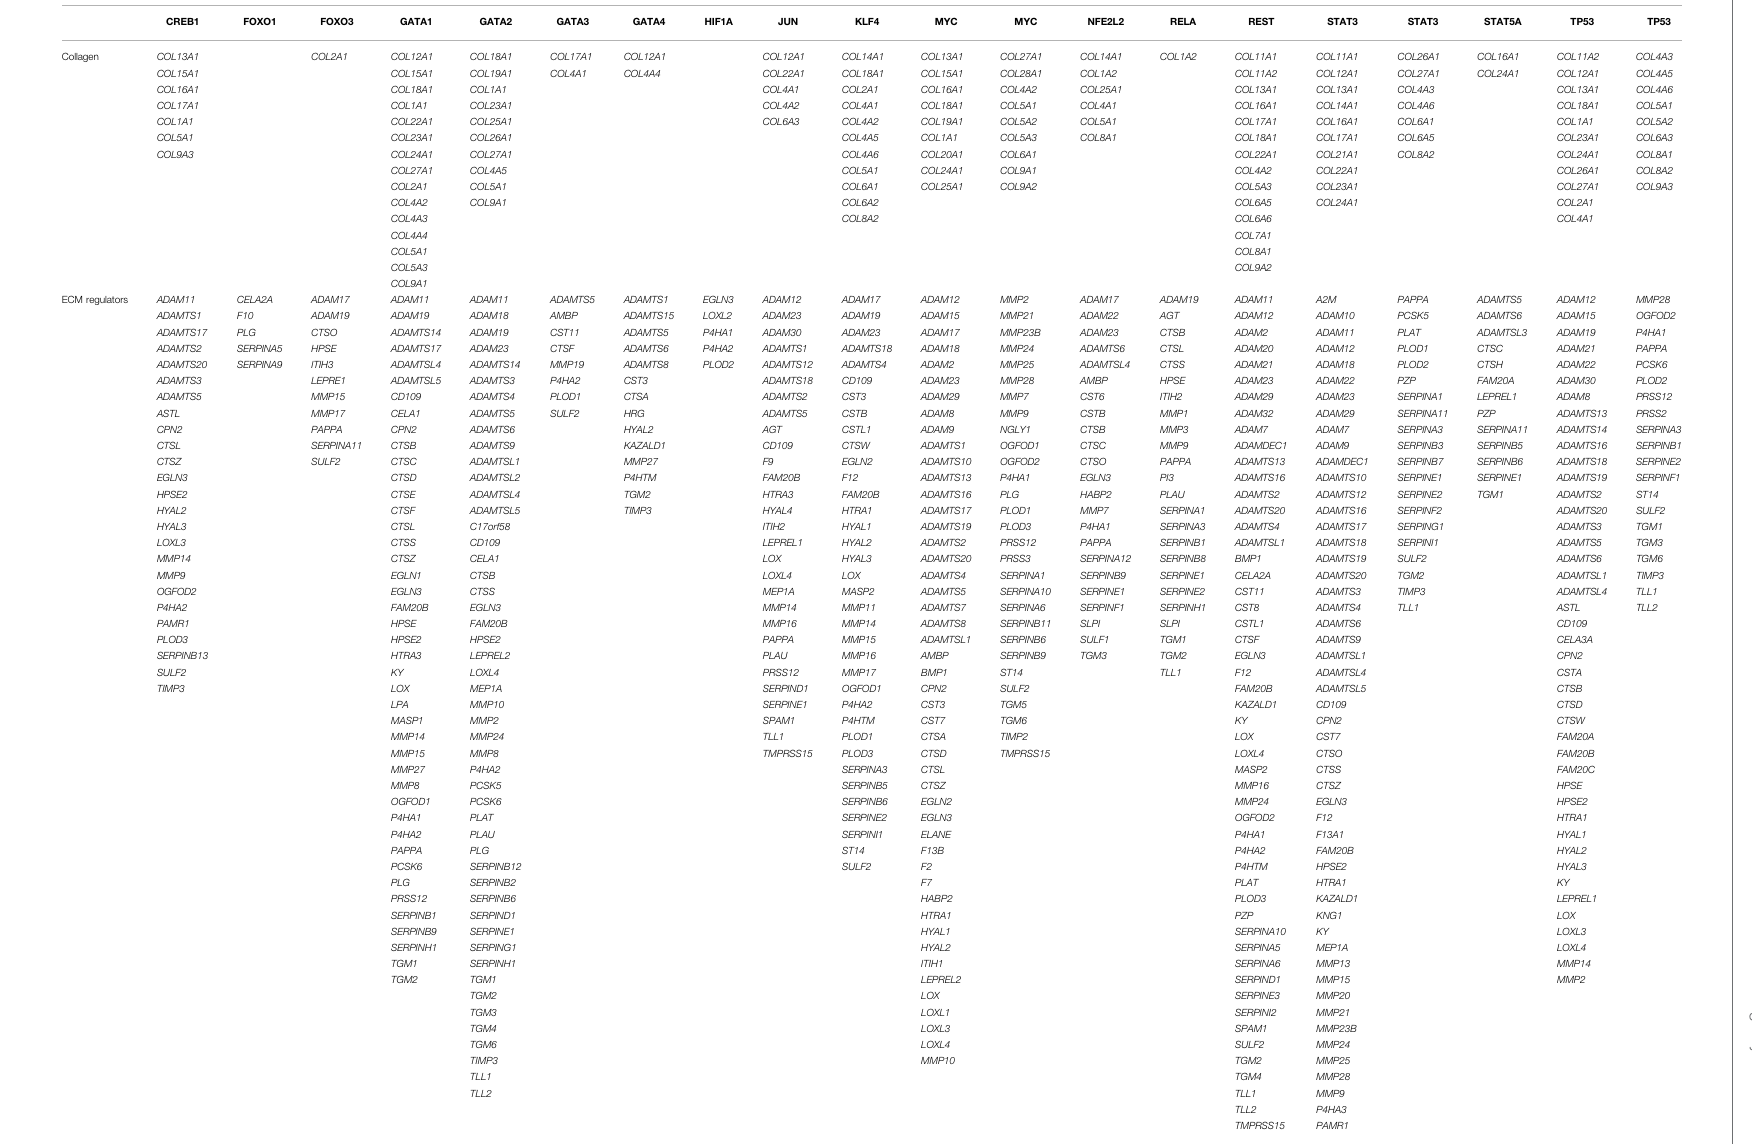
TABLE 1 | List of transcription factor target genes from ChIP-seq studies strati fi ed to collagen and ECM regulators matrisome gene categories. CREB1 Collagen COL13A1